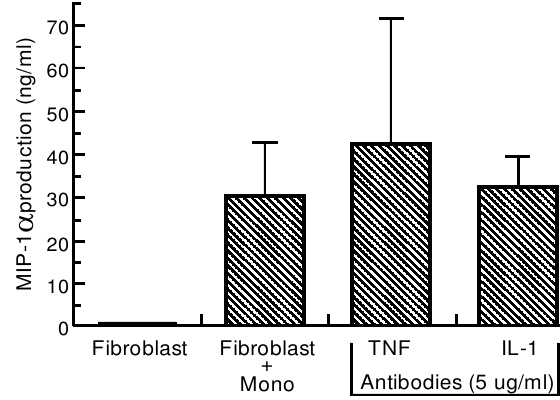
FIG. 1. MIP-1 a production during fibroblast–monocyte inter- action. Enriched monocyte populations were layered onto fibroblast monolayers. Either the monocytes or the fibroblast were fixed with 4% paraformaldehyde (5min) and MIP-1 a levels were determined in 2h culture supernatants. MIP-1 a was generated by monocytes but not fibroblasts. Data represents Mean ± SE from two different experiments. * P <0.05.